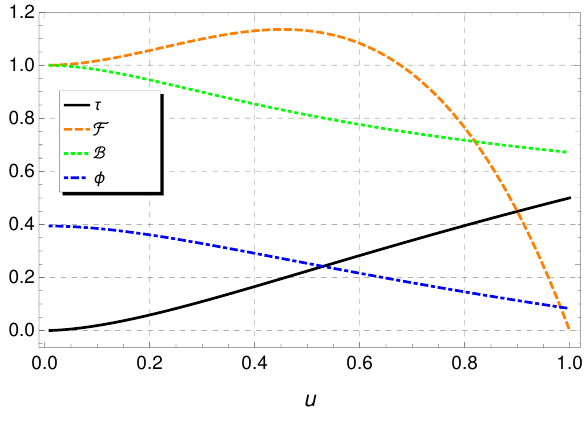
Figure 3 . The solutions for ;